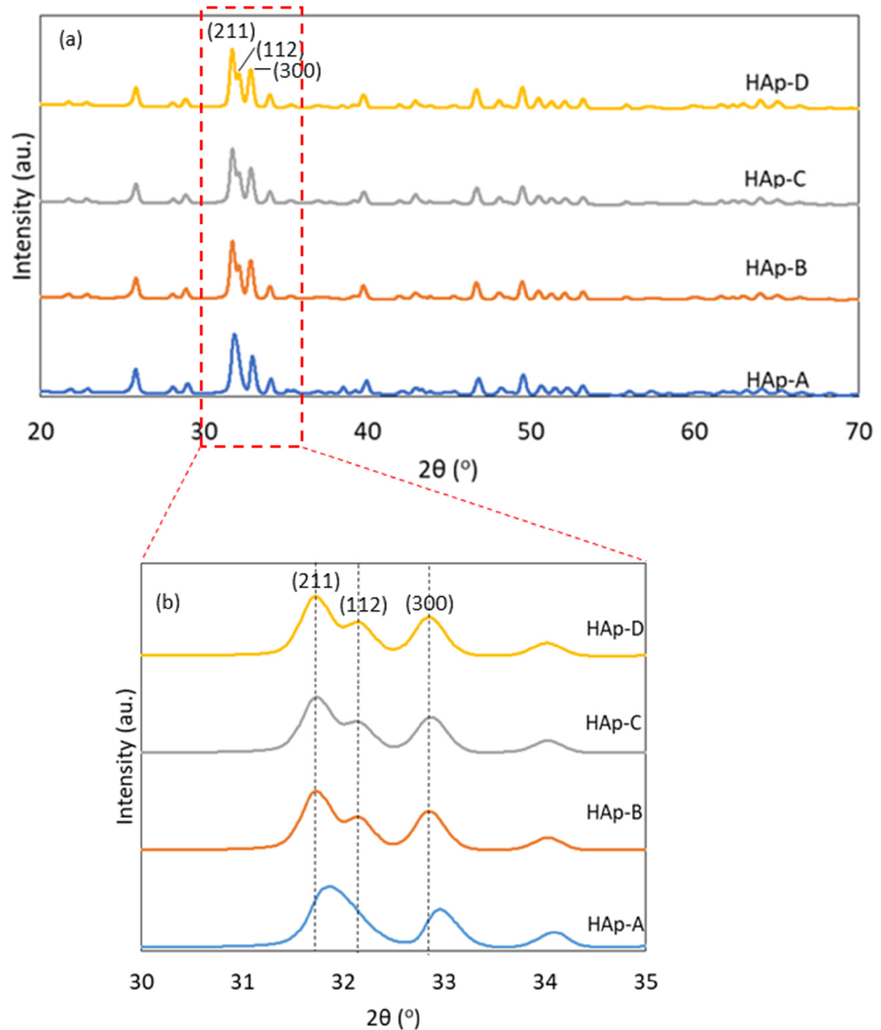
Figure 1. ( a ) X-ray diffractogram and ( b ) expanded X-ray diffractogram of the HAp powders taken from several batches of similar calcination process. Table 1. The lattice constant of the HAp powders.